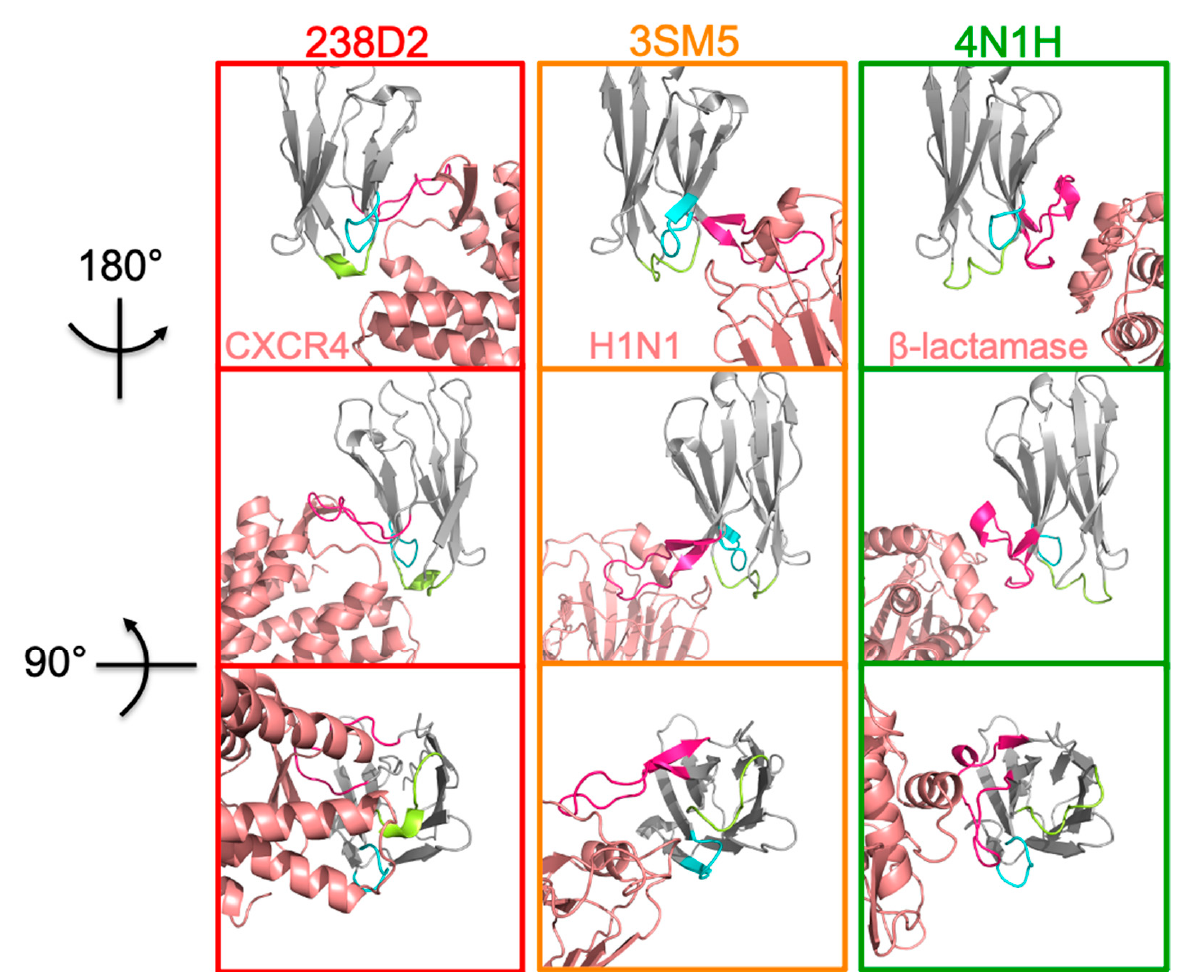
Figure 2. Structural comparisons of 238D2, 3SM5, and 4N1H with their cognate targets. 238D2 on CXCR4 (left panels, MAbTope prediction), 3SM5 on hemagglutinin (middle panels, crystallographic structure), and 4N1H on β -lactamase (right panels, crystallographic structure). The Nb frameworks are shown in gray, CDR1 in blue, CDR2 in green, and CDR3 in magenta. The antigens are shown in salmon.